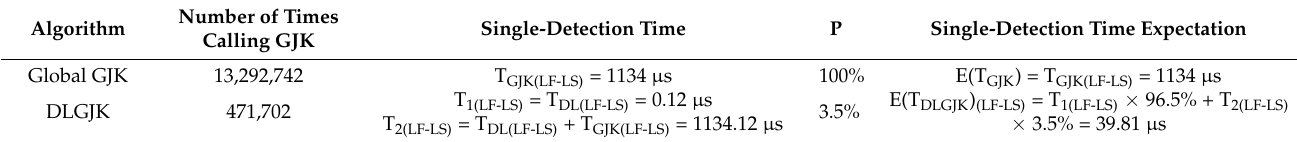
Table 7. LF-LS workspace self-collision detection time expectation of Global GJK and DLGJK.